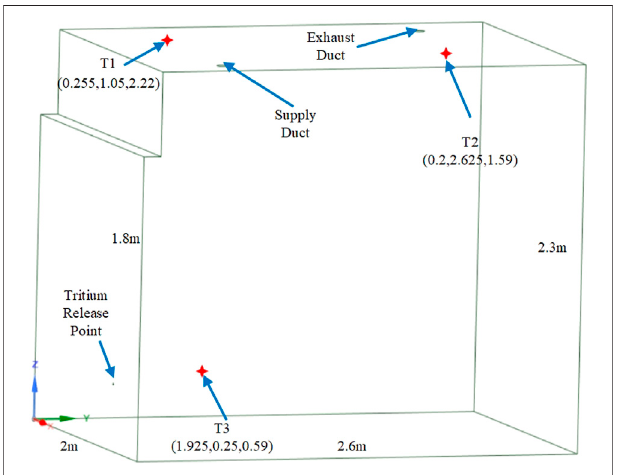
FIGURE 3 | Geometrical model of Caisson. FIGURE 4 | Tritium concentration comparison between experimental results and calculated results at monitoring